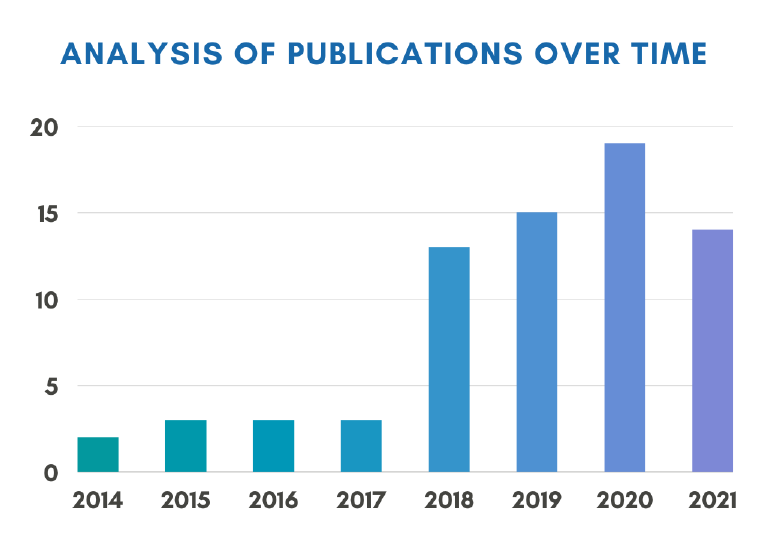
Figure 2. Publications over